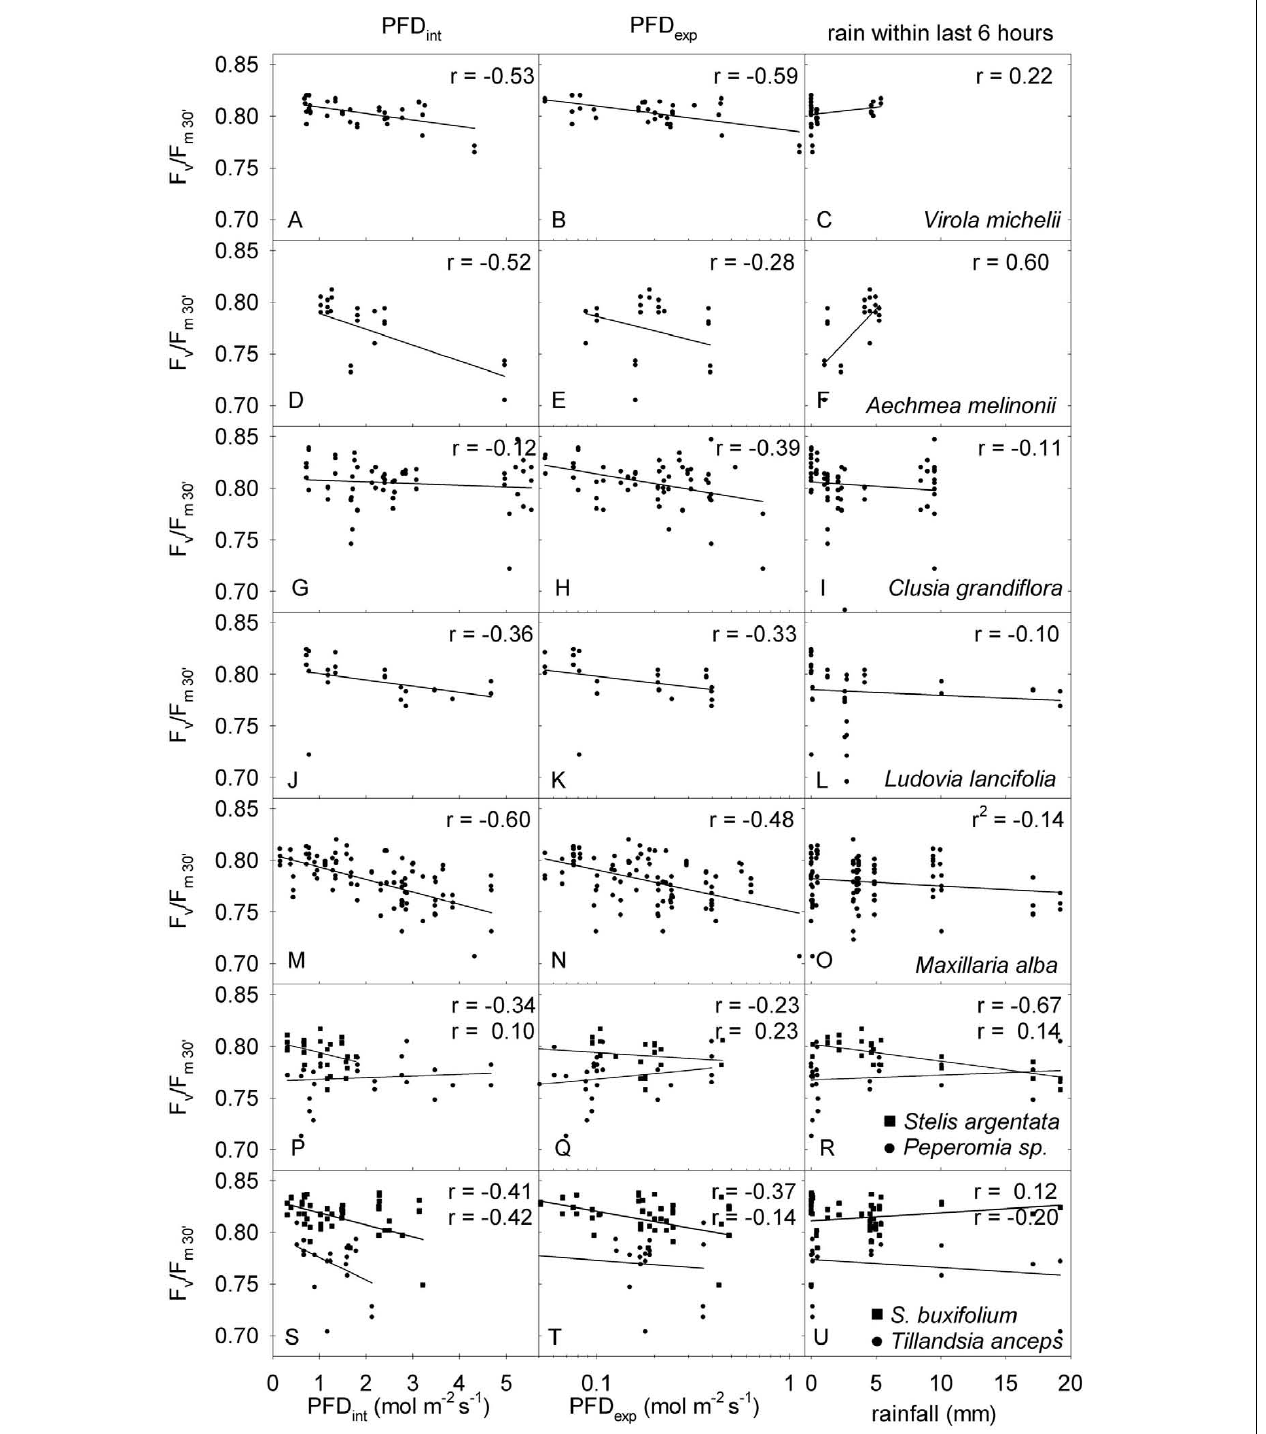
FIGURE 6 | Correlation analyses between dynamically restored potential quantum yield after 30min of dark adaptation ( F v / F m30 (cid:2) ) and integrated PFD perceived until the measurement (PFD int , left column), exponentially weighted PFD perceived during the last 3h (PFD exp , middle column), and